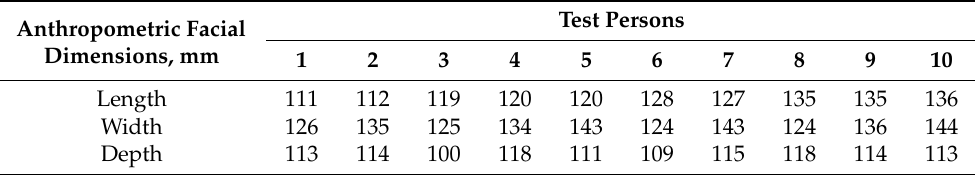
Table 4. Anthropometric facial dimensions of the experimental group participating in the experiment.